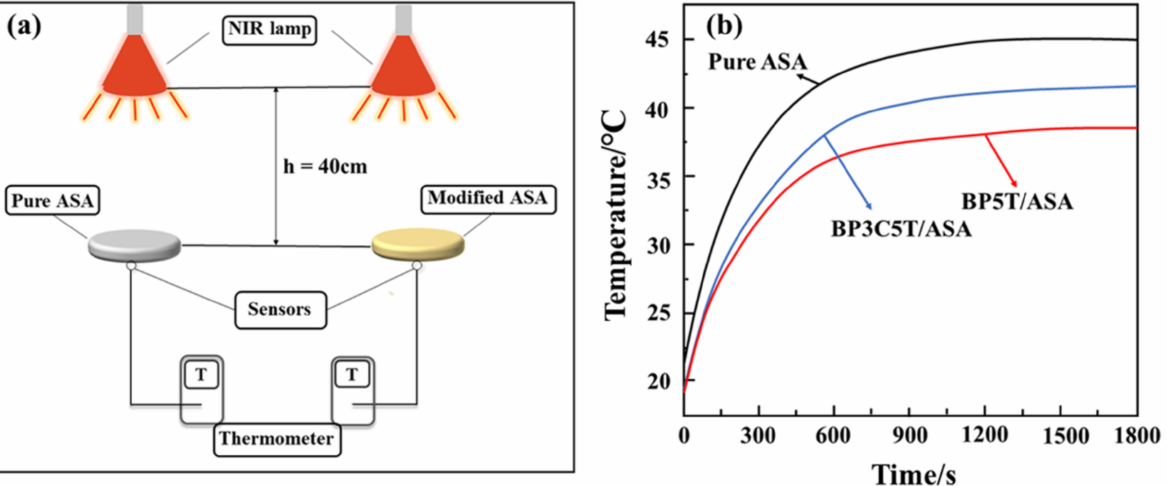
Figure 1. ( a ). NIR lamp radiation test setup, ( b ). Heating curves of pure ASA and modified ASA [4] Copyright 2021 with permission from